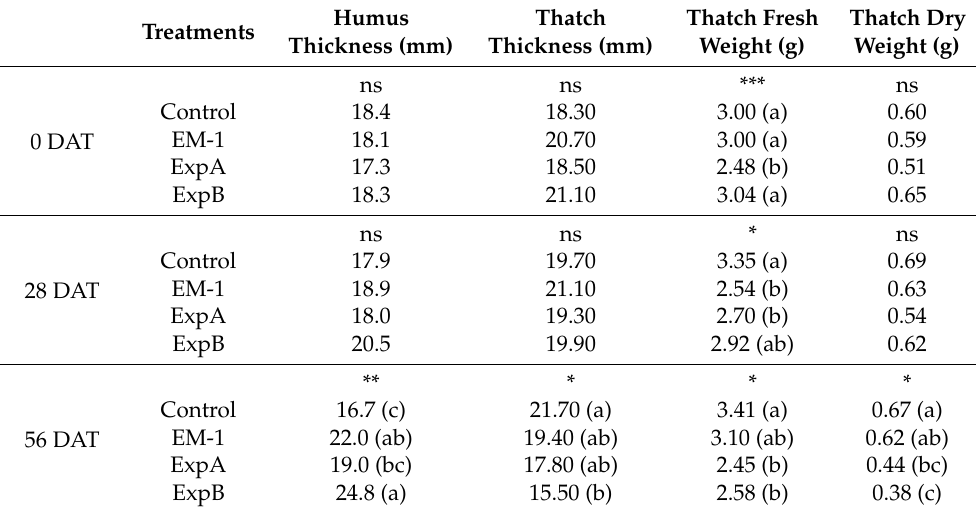
Table 5. Changes in thatch thickness and thatch fresh and dry weight, respectively, at 0, 28 and 56 DAT with the untreated control, EM-1, ExpA and ExpB. Humus Thatch Thatch Fresh Thatch Dry Treatments Thickness (mm)